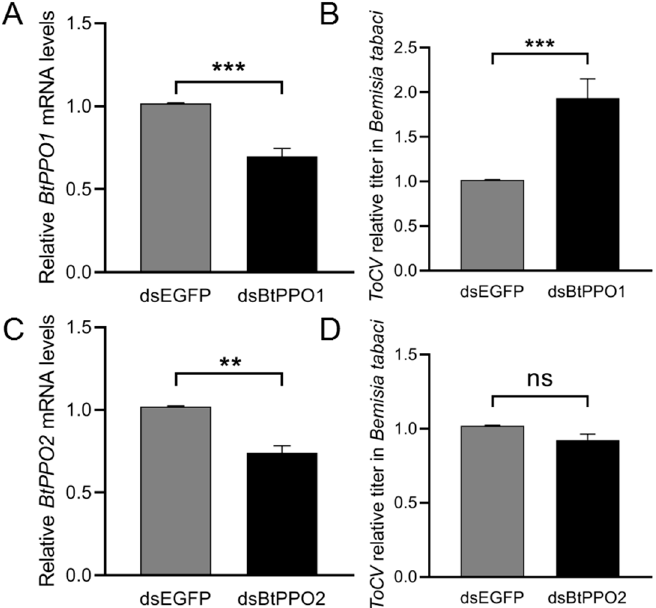
Figure 5. Efficiency of RNA interference and the effects on ToCV acquisition by Bemisia tabaci . ( A ) Relative mRNA levels of BtPPO1 in B. tabaci adults after feeding on a diet containing dsEGFP and dsBtPPO1. ( B ) Effect of BtPPO1 gene silencing on ToCV titer in B . tabaci feeding on ToCV-infected tomato plants at 24 h. Data of ( A , B ) presented as the mean ± SE for eight independent replicates. ( C ) Relative mRNA levels of BtPPO2 in B. tabaci adults after feeding on a diet containing dsEGFP and dsBtPPO1. ( D ) Effect of BtPPO2 gene silencing on ToCV titer in B. tabaci feeding on ToCV ‐ infected tomato plants at 24 h. Data of ( C , D ) presented as the mean ± SE for six independent replicates. The data were normalized to the expression of SDHA and EF ‐ 1 α . Asterisks’ indicate significant differ ‐ ences between the treatment and the corresponding untreated control according to the Student’s t ‐ test. ** p < 0.01, *** p < 0.001, ns indicates no significant difference.